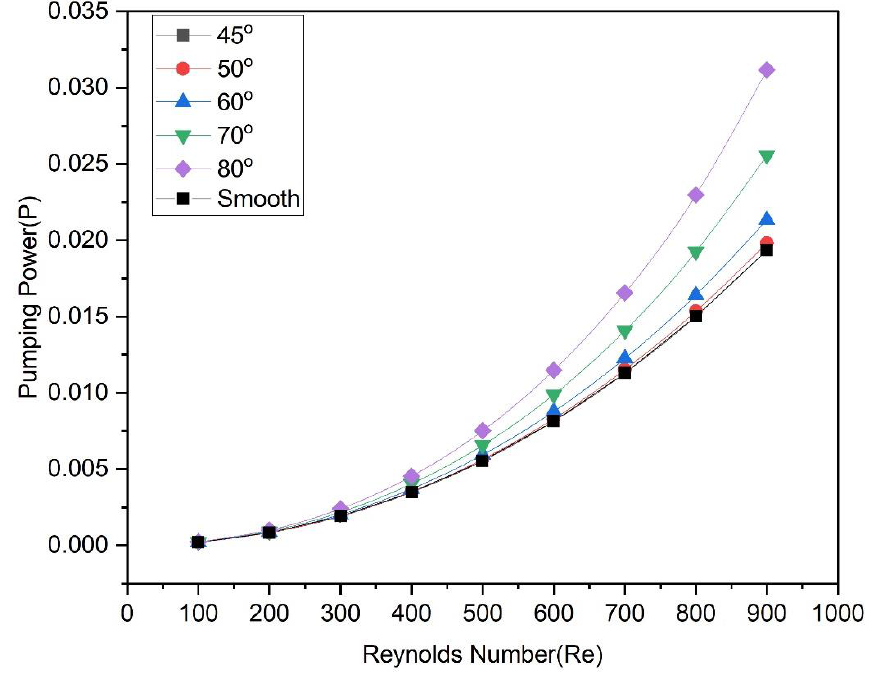
Figure 13. Pumping power varies with Reynolds number for various angles.